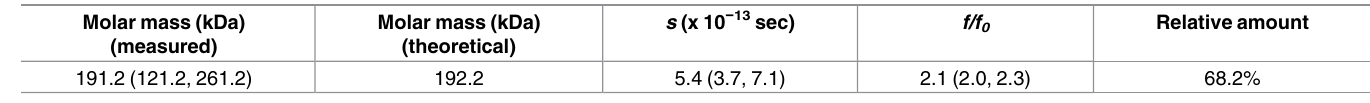
Values in parenthesis are 95% confidence intervals from the peak integration. This transformation to absolute molar mass is based on an estimated partial specific volume of 0.740 ml/g.